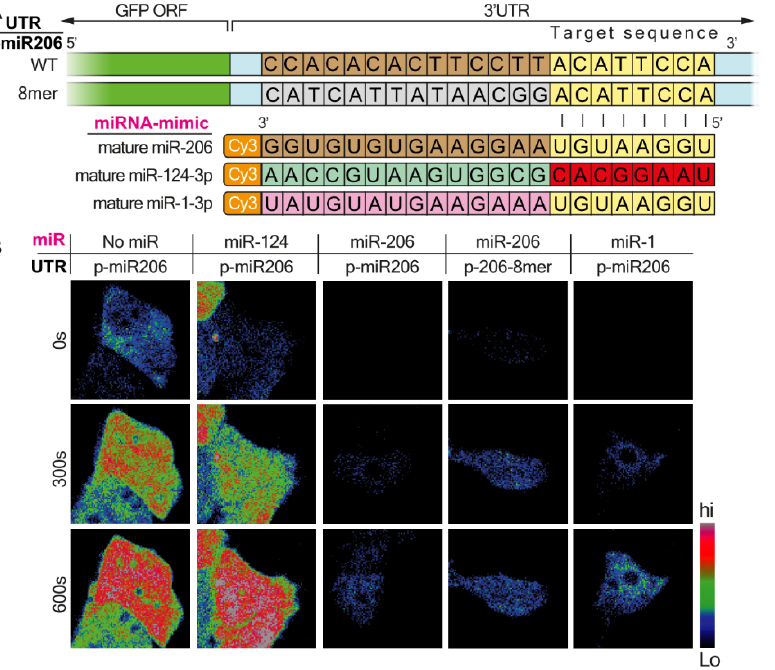
Figure 2. Target GFP downregulation as a function of canonical site variations applies also for miR- 206-3p . ( A ) Schematic illustration of the experimental setup. Two dGFP expression plasmids con- taining miR-206-3p canonical sites in the 3′UTR of dGFP were each co -transfected together with mature Cy3-miR-206 or mature Cy3-miR-1, or mature Cy3-miR-124 as a control, into 293T cells. Green indicates the GFP coding sequence (CDS); light blue indicates the 3′UTR of dGFP; nucleotides labeled in brown indicate nucleotides in full complementation to mature miRNA; nucleotides la- beled in grey indicate random nucleotides not complementing the full sequence of mature miR-1; nucleotides labeled in yellow and red indicate nucleotides in the miRNA target sequence that are complementary and non-complementary, respectively, to the seed sequence; nucleotides labeled in light-green and pink highlight the sequence differences between mature miR-206, miR-124, and miR-1. ( B ) Representative images of dGFP in 293T cells carrying miR-206 canonical sites in 3′U TR. The images show three time points for each cell: 0 minutes, 5 minutes, and 10 minutes after photo- bleaching. ( C ) The graph shows the cumulative percent of fluorescence of dGFP during the 10 minutes following photobleaching. The horizontal K R50 line indicates the Y value at which 50% of the maximal recovery is achieved in the non-targeting control. ( D ) Quantification of the mean slope of dGFP recovery after photobleaching. Ordinary one-way ANOVA **** p < 0.0001. Post-hoc multi- ple comparisons: * p -value < 0.05, ** p -value < 0.01, **** p -value < 0.0001. 3.2. Synthetic miRNA Containing Seed Modifications Differentially Regulate Protein Synthesis